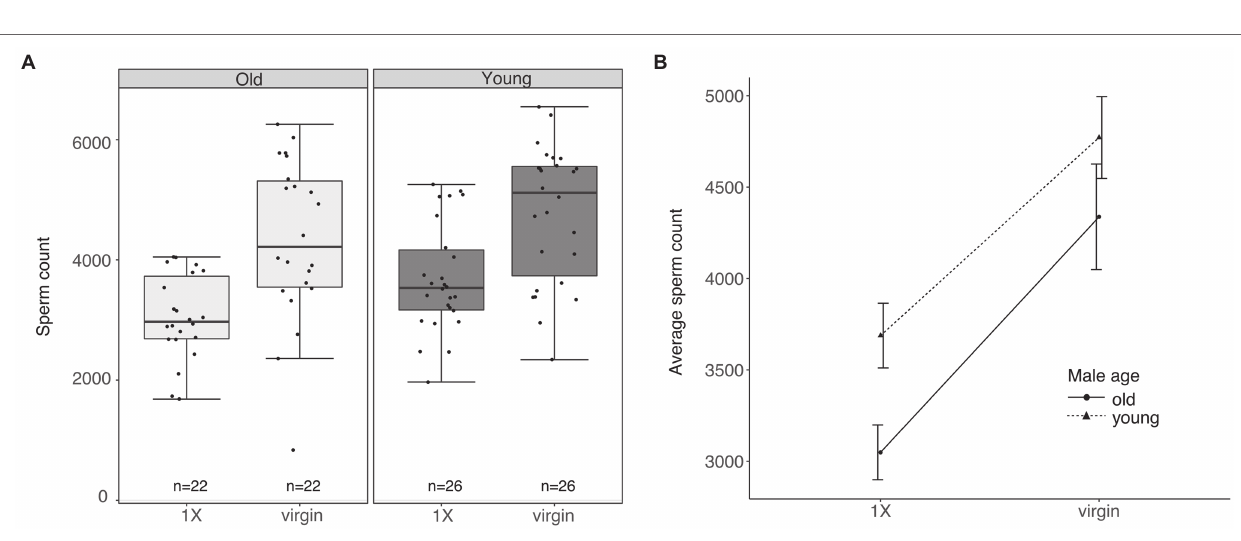
FIGURE 3 | Old and young males transfer similar amounts of sperm to their mates. (A) Total sperm contained in the seminal vesicles of virgin and once mated (1X) males of both age groups. The middle horizontal line in the box plots represents the median, the lower and upper margins of the box represent the 25th and 75th quartiles, and the whiskers extend to the minimum and maximum of the data (excluding outliers, shown as points outside the whiskers). (B) Mean (±SE) seminal vesicle sperm in virgin and 1X males of both age